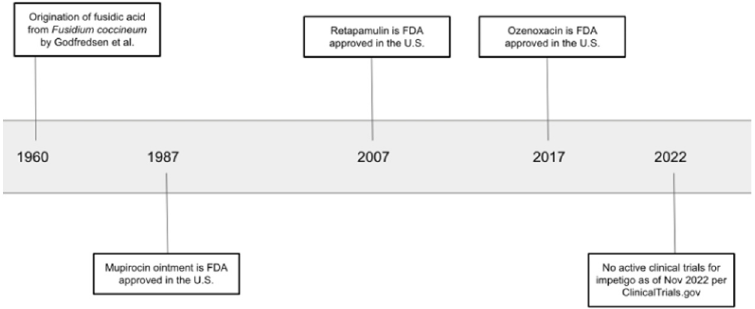
Figure 1. Timeline of discovery and approval of topical antibiotics for impetigo [55–57].